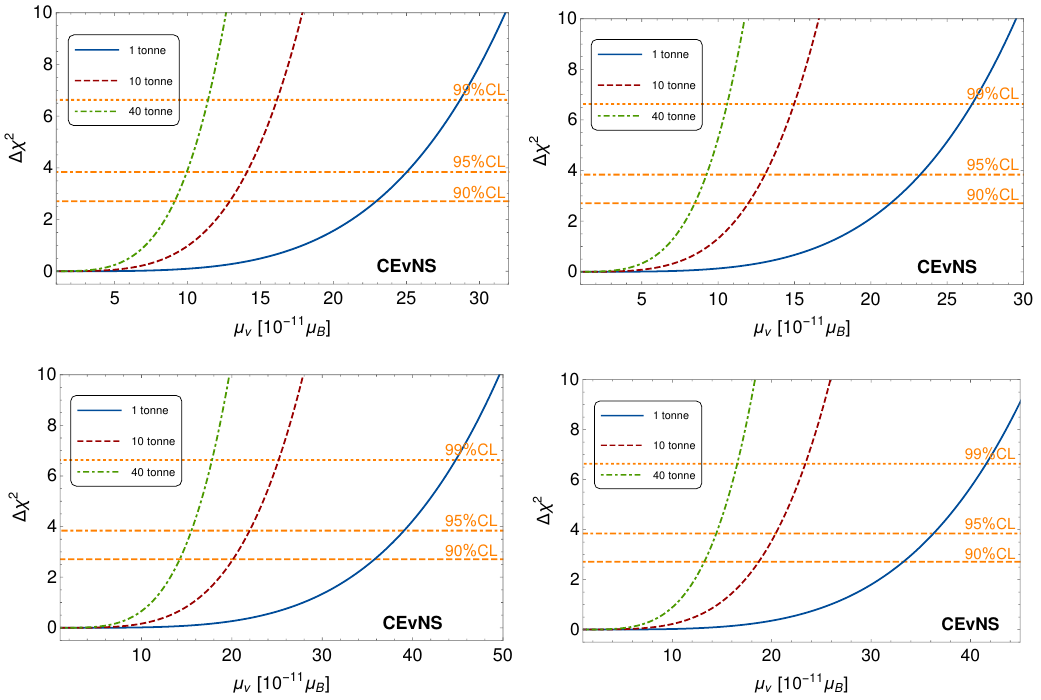
Figure 3 . Top graphs : nuclear recoil sensitivities to neutrino magnetic dipole moments in a 1, 10 and 40 tonne active volume detectors during a one-year data taking. The result assumes a 0 . 3 keV threshold, 100% detector efficiency and backgrounds amounting to 68% (left) and 25% (right) of the signal rate, Bckg 1 and 2 hypotheses respectively. Bottom graphs : same as top graphs, but assuming a 1 keV threshold. In contrast to electron recoils, results are rather sensitive to threshold